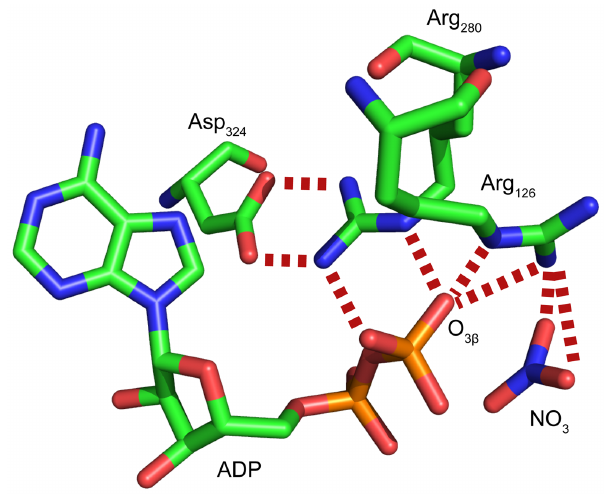
Figure 12. Arginine kinase active site mutation. Selected interactions of the nucleotide in the crystal structure of the transition state analog complex of Horseshoe Crab Arginine Kinase (AK, PDB ID 1M15) [48]. Carbon=green, nitrogen=dark blue, oxygen=red and phosphorus=orange. In AK, Arg 280 contacts the O 3 b oxygen of ADP, an a -oxygen and the Asp 324 side chain. In ATP, the O 3 b oxygen bridges to the c -phosphate which is mimicked by nitrate in this transition state analog complex. Hydrogen bonds are shown with red dotted lines.